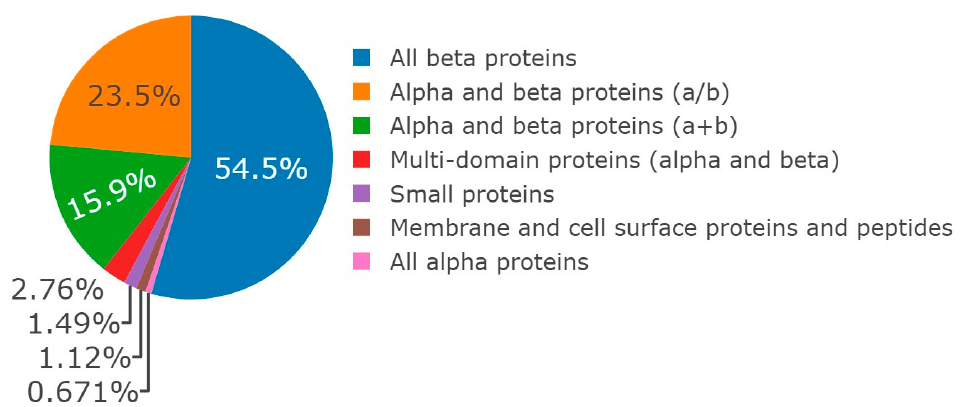
Figure 3. Histogram of the distribution of protein classes (all beta, all alpha, alpha + beta, alpha/beta) and SCOP folds within the study dataset.